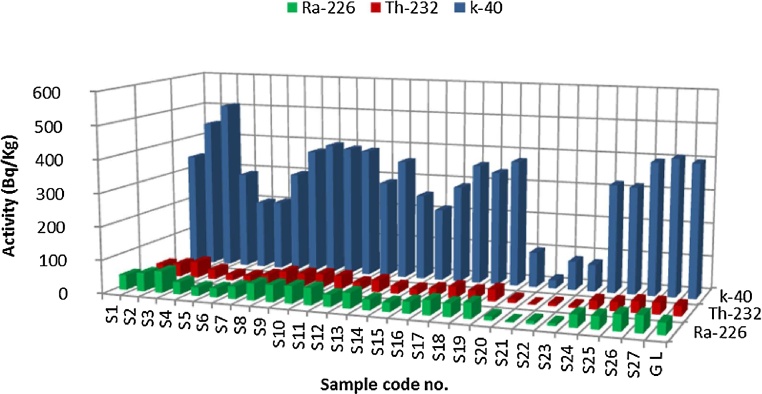
Activity concentrations of 226Ra, 232Th and 40 K (Bq/Kg) in different locations of Al Madinah, Saudi Arabia and last column represents the global limits.